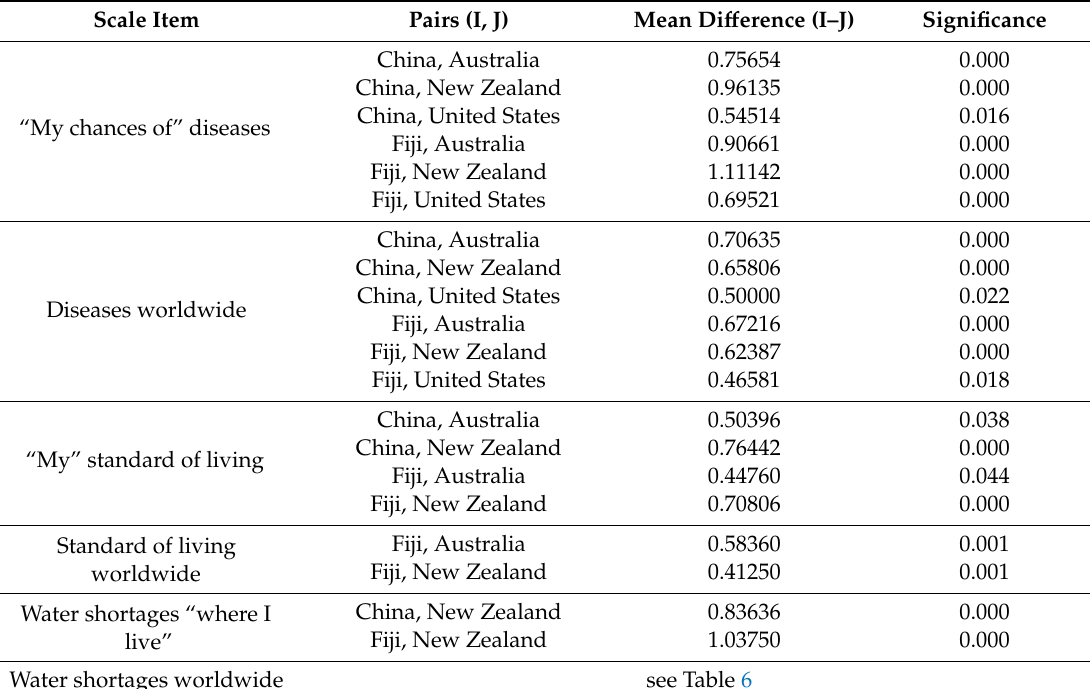
Table 5. Tukey HSD post-hoc analysis comparing China and Fiji to developed countries.